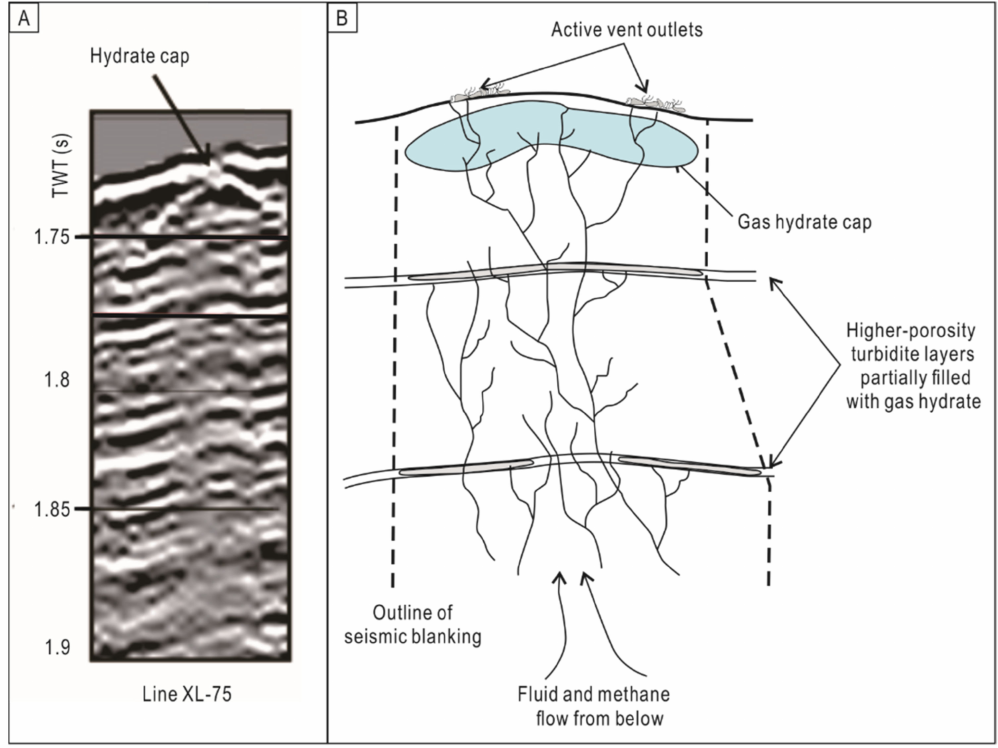
Figure 22. ( A ) A single-channel seismic profile exhibiting a hydrate cap on the top of the blanking below. ( B ) Conceptual model for the formation of the seismic blank zone. Hydrates are distributed in a network of fractures. Layered hydrates can accumulate through the lateral permeable turbidite layers comprising coarser-grained sediments (cited from